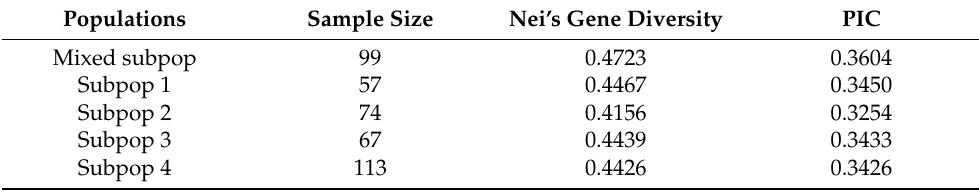
Table 5. Genetic diversity of 410 faba bean accessions based on structure population analysis. Populations Sample